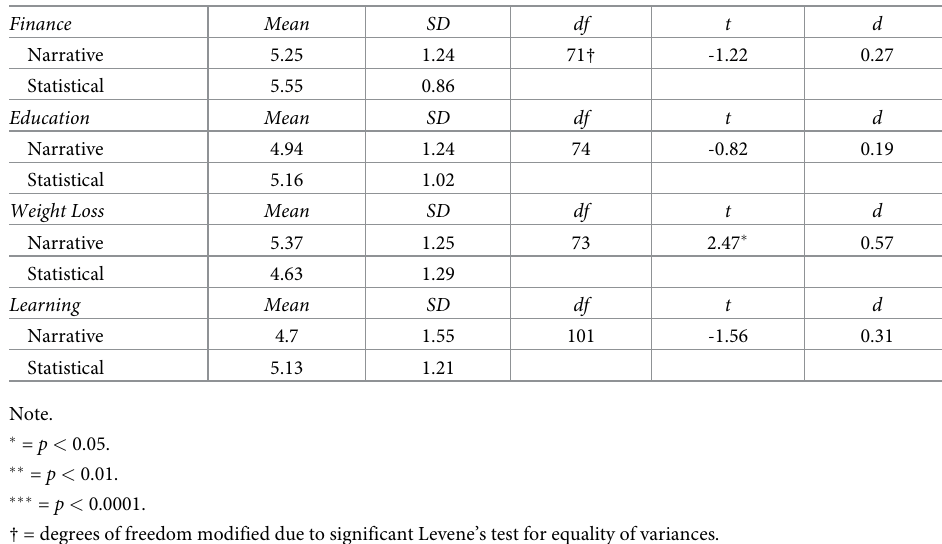
Table 1. Quality judgments for arguments across domains.